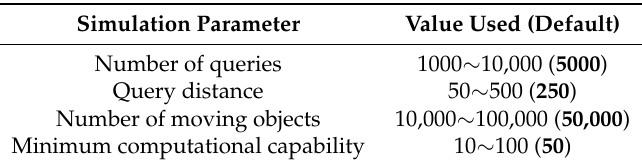
Table 2. Simulation parameters and their